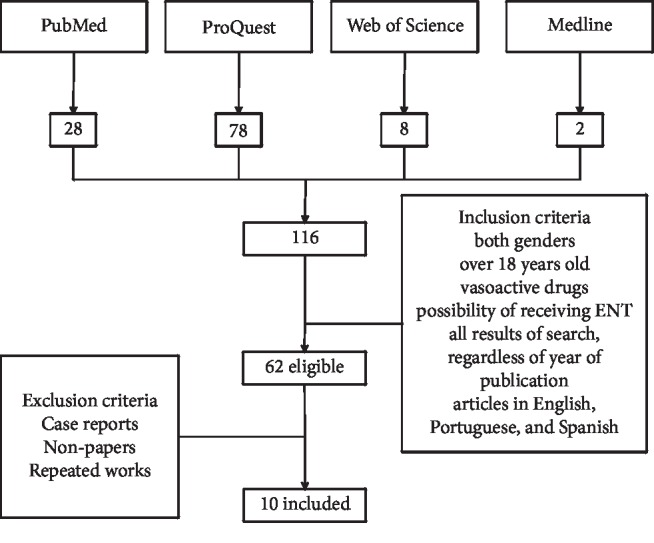
Articles selected with search strategy.